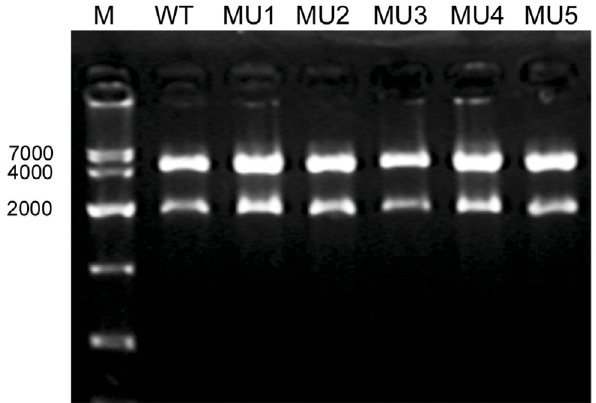
Figure 1. Double restriction enzyme identification of pGL3- CYP2E1 with BglII and HindIII. WT: wide type; MU1: 2 1778G . A; MU2: 2 1646A . G; MU3: 2 971A . C and 2 962A . G; MU4: 2 792T . G; MU5: 2 722A . G. doi:10.1371/journal.pone.0040883.g001 PLoS ONE |